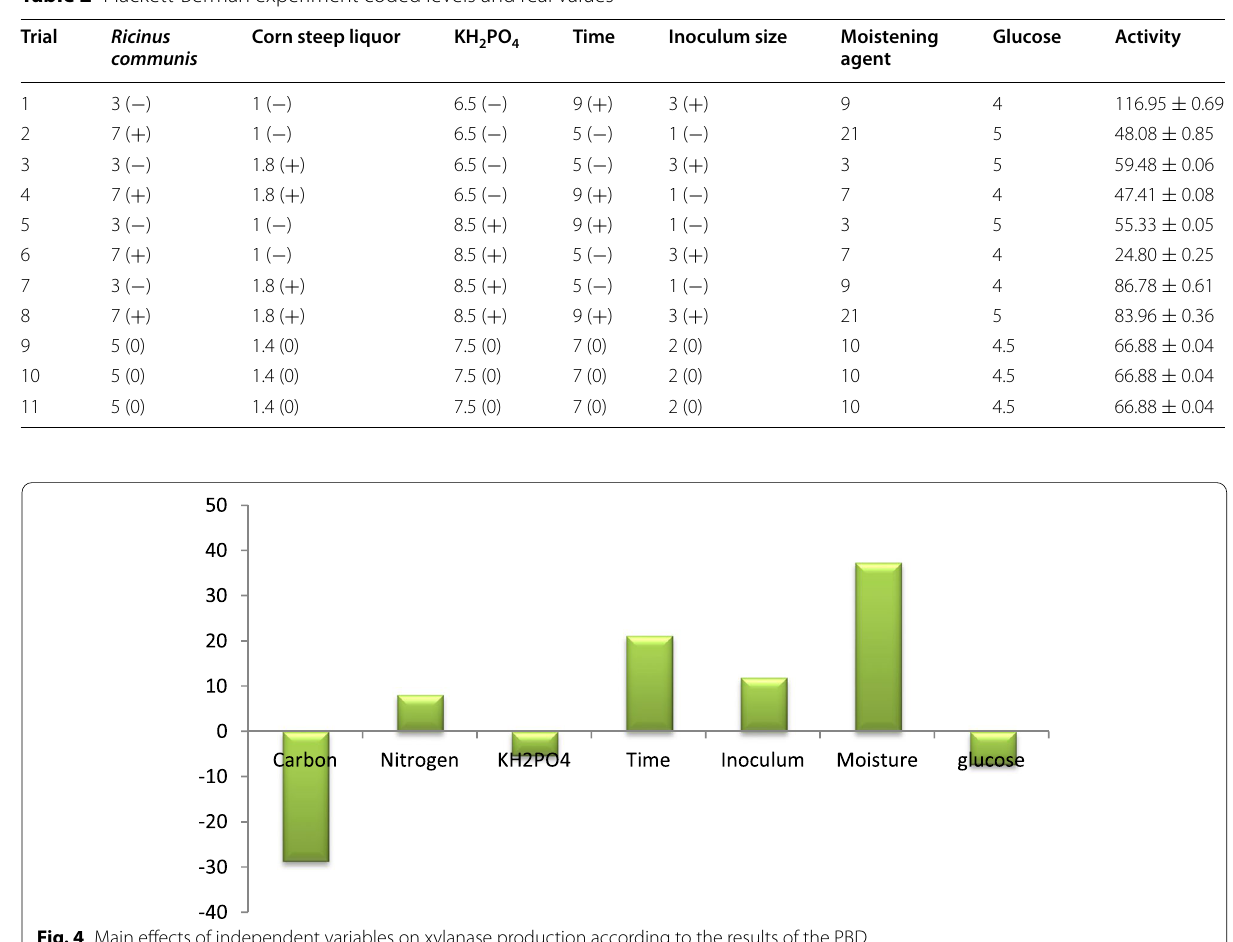
Fig. 4 Main effects of independent variables on xylanase production according to the results of the